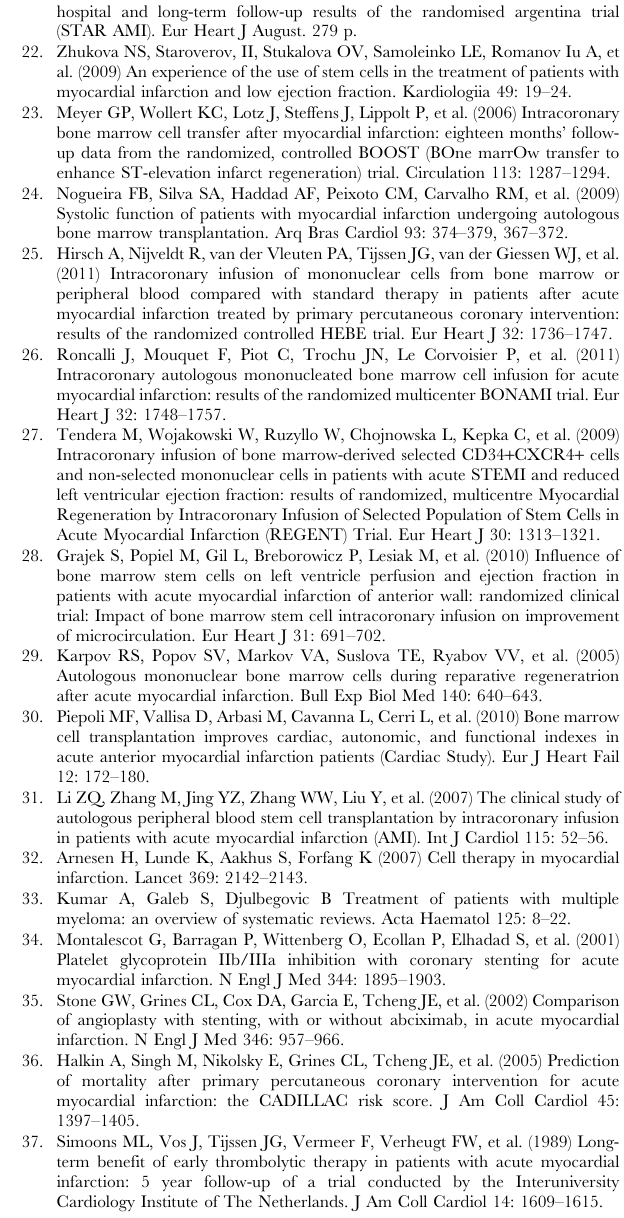
Table S5 Reference to